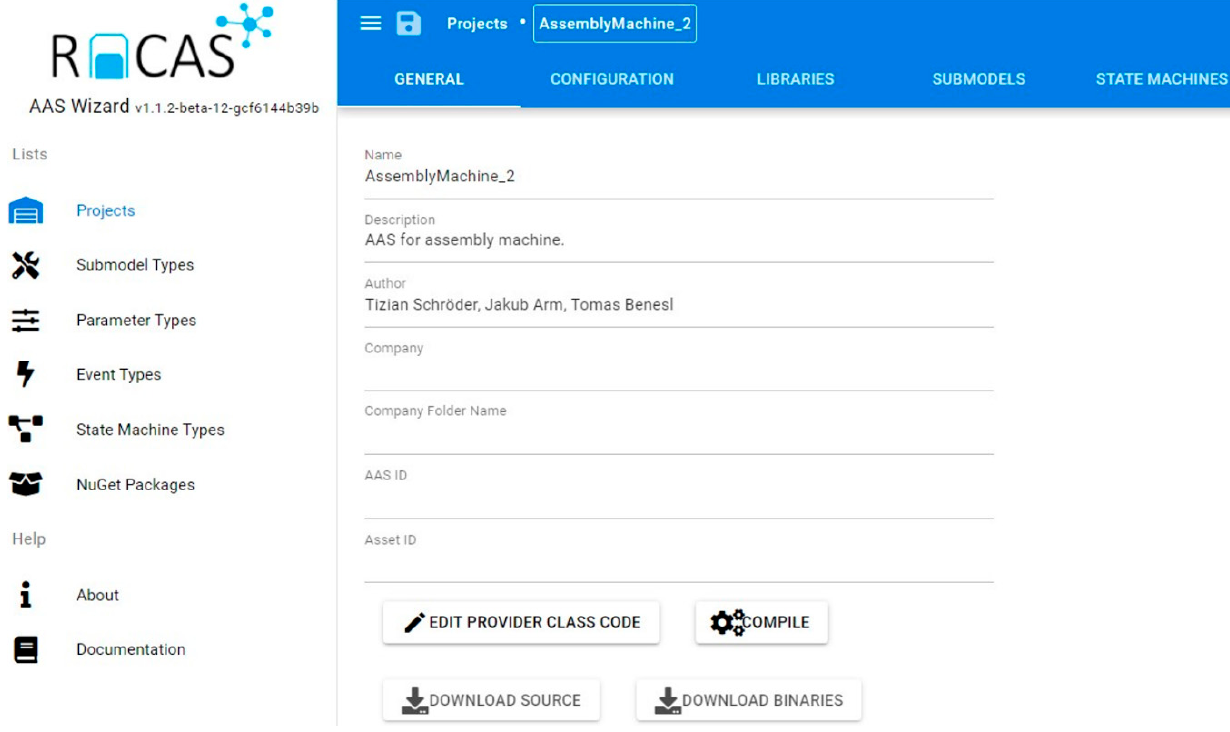
Figure 5. A ConfigWizard screenshot: front end. Table 1. The OPC UA ISO/OSI